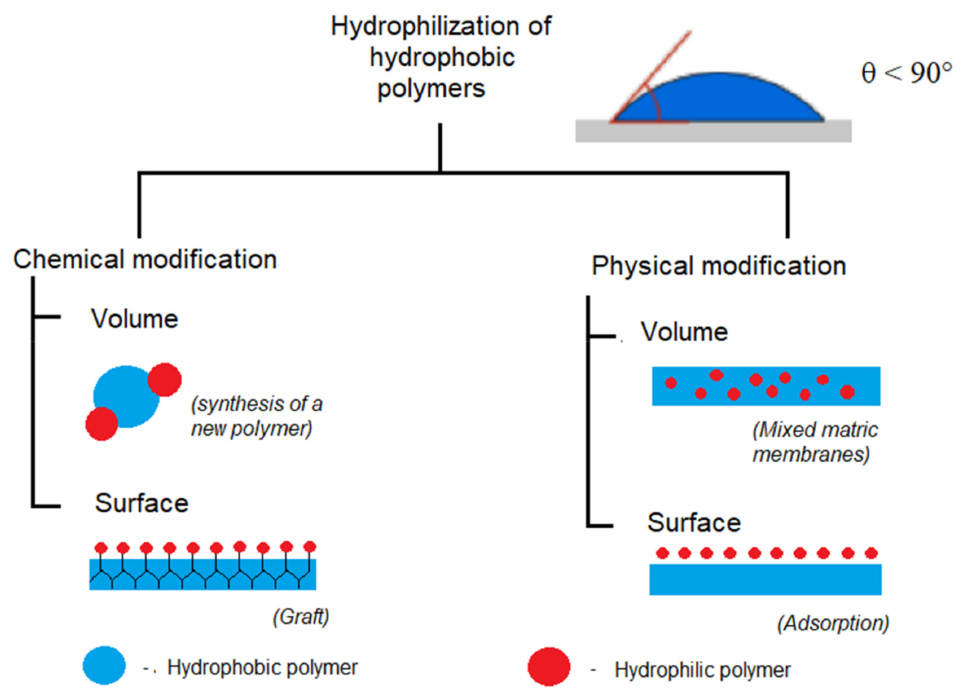
Figure 4. General approaches to the hydrophilization of hydrophobic